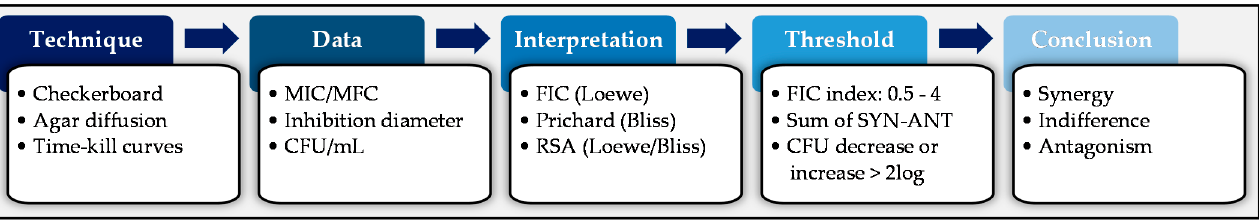
Figure 1. Summary of steps needed to perform and interpret antifungal combination tests. MIC, minimal inhibitory concentration; MFC, minimal fungicidal concentration; CFU, colony forming unit; FIC, fractional inhibitory concentration; RSA, response-surface analysis; SYN, synergy; ANT, antagonism.